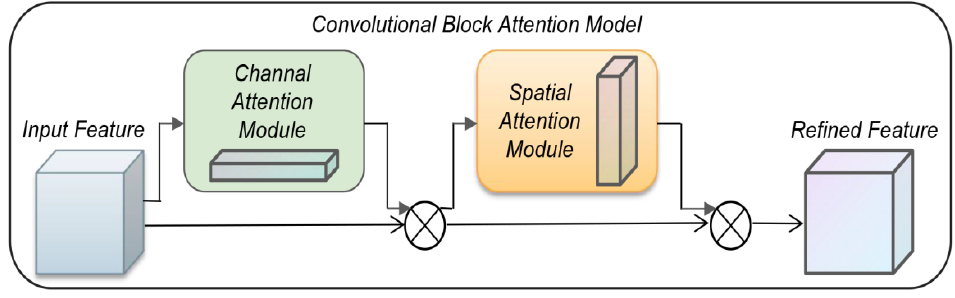
Figure 6. CBAM structure